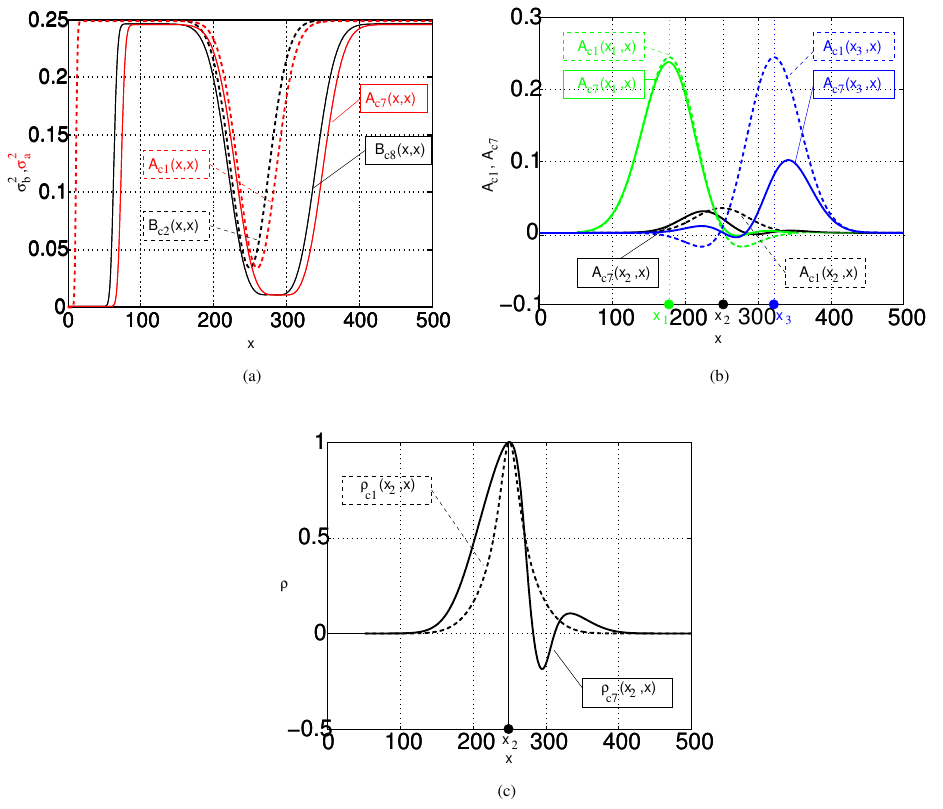
Fig. 15. (a) Error variance at each point for cycle one (dashed curves): analysis A c1 (red) and B c2 (black), and for cycle seven (solid curves): analysis A c7 (red) and B c8 (black). (b) Analysis error covariances in A c1 (dashed curves) and in A c7 (solid curves) for points x 1 = 180 (green), x 2 = x obs = 250 (black) and x 3 = 320 (blue). (c) Error correlation in B c1 (dashed curve) and B c8 (solid curve) for x 2 = x obs .